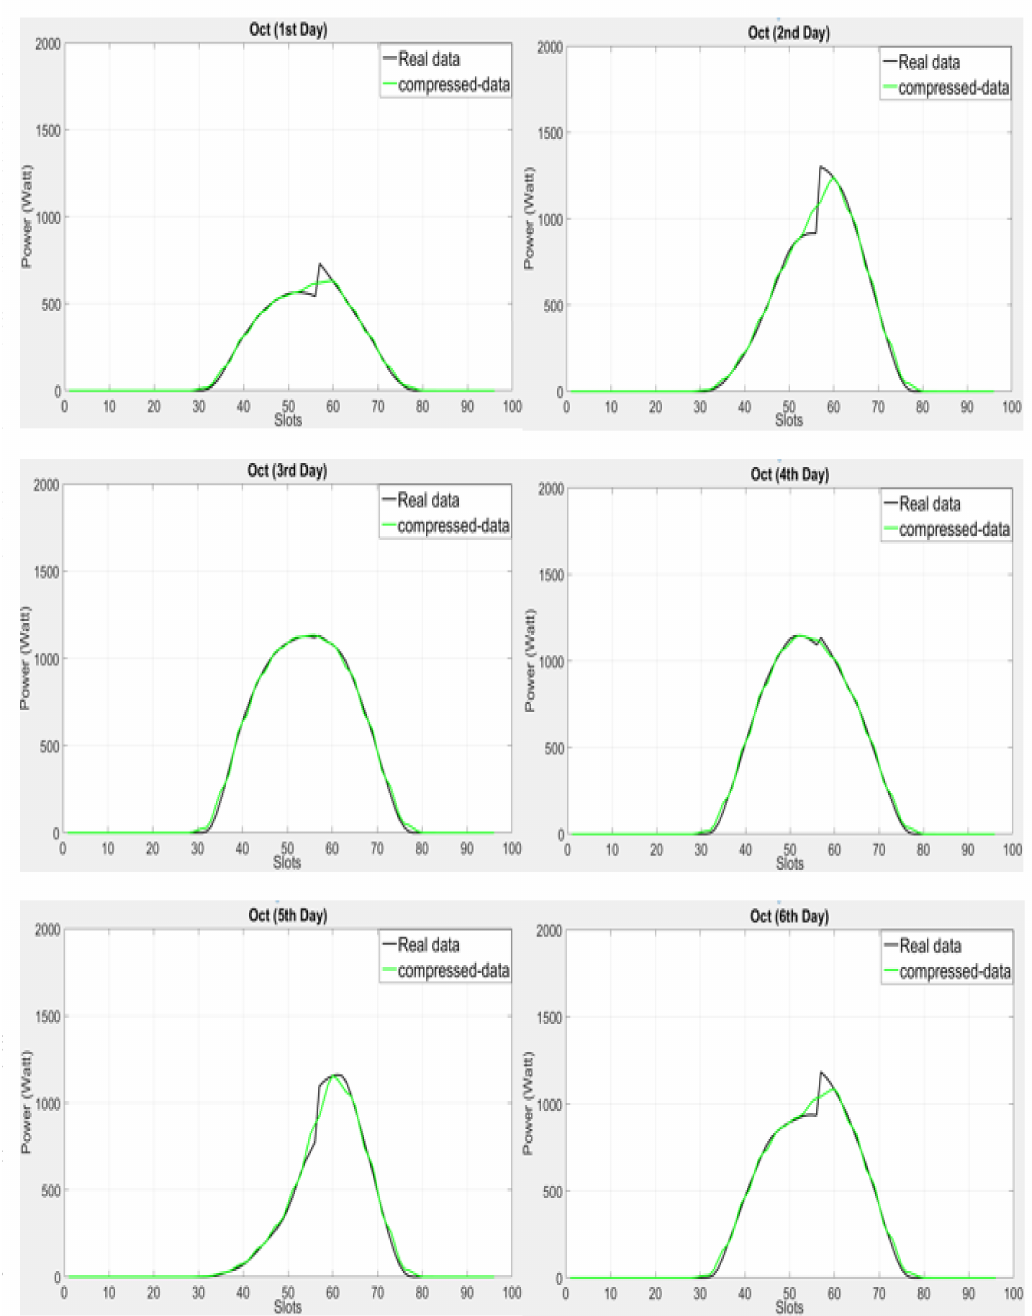
Figure 6. Graphical representation of compressed profile method against the real data based on the shorter (15-min data interval) time period horizon of solar energy profile (Elia) with 96 time slots in 24